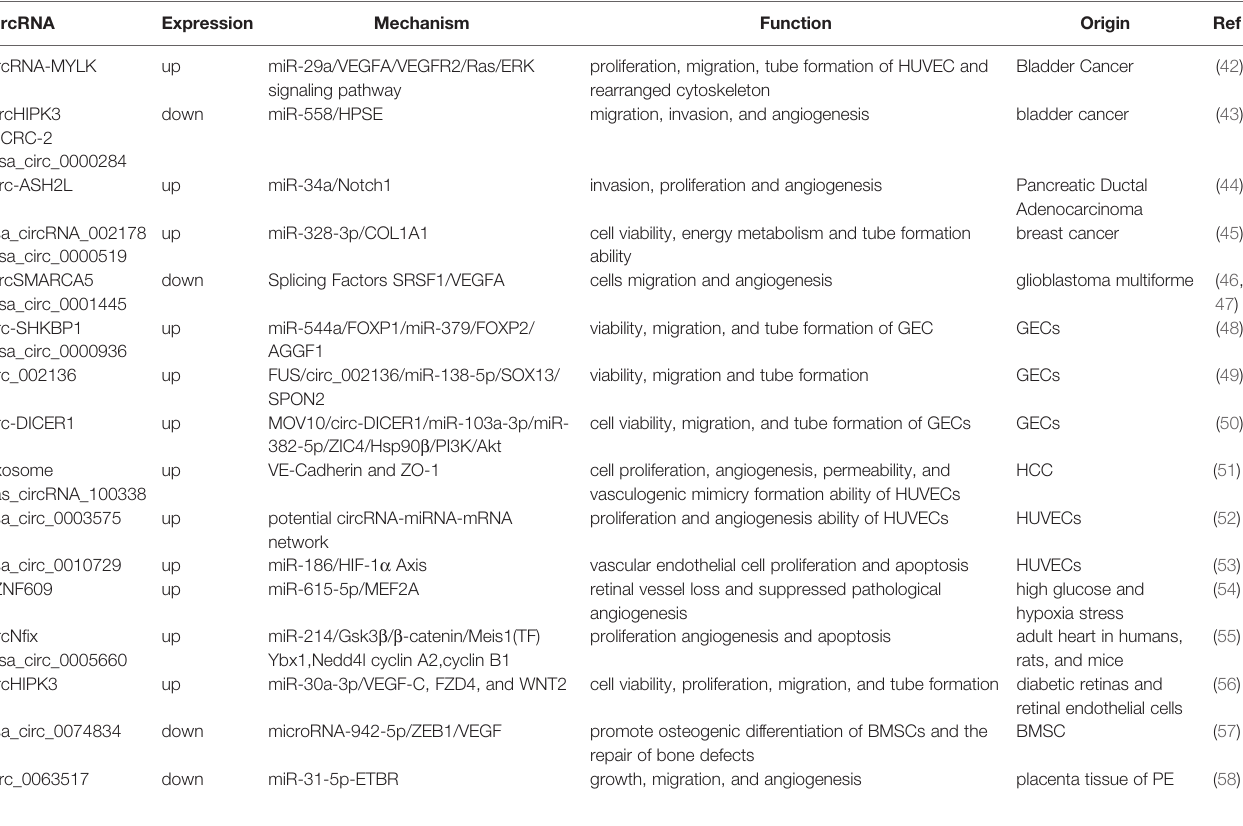
TABLE 1 | The expression patterns, mechanism, and functions of circRNAs associated with tumor angiogenesis.